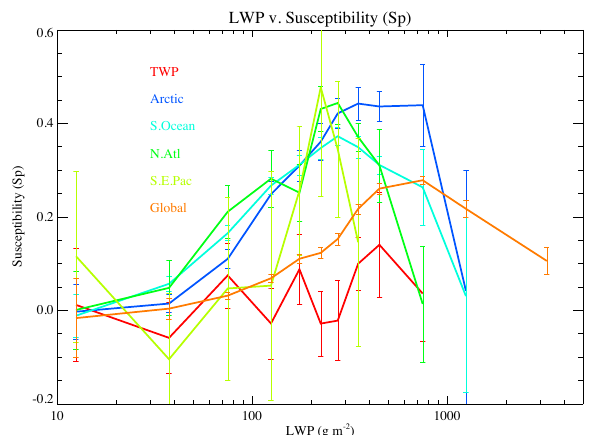
Fig. 7. Regional averages of precipitation susceptibility ( S p ) as de- scribed in the text for different regions (colors, see Fig. 5 for de- scription) binned by LWP.